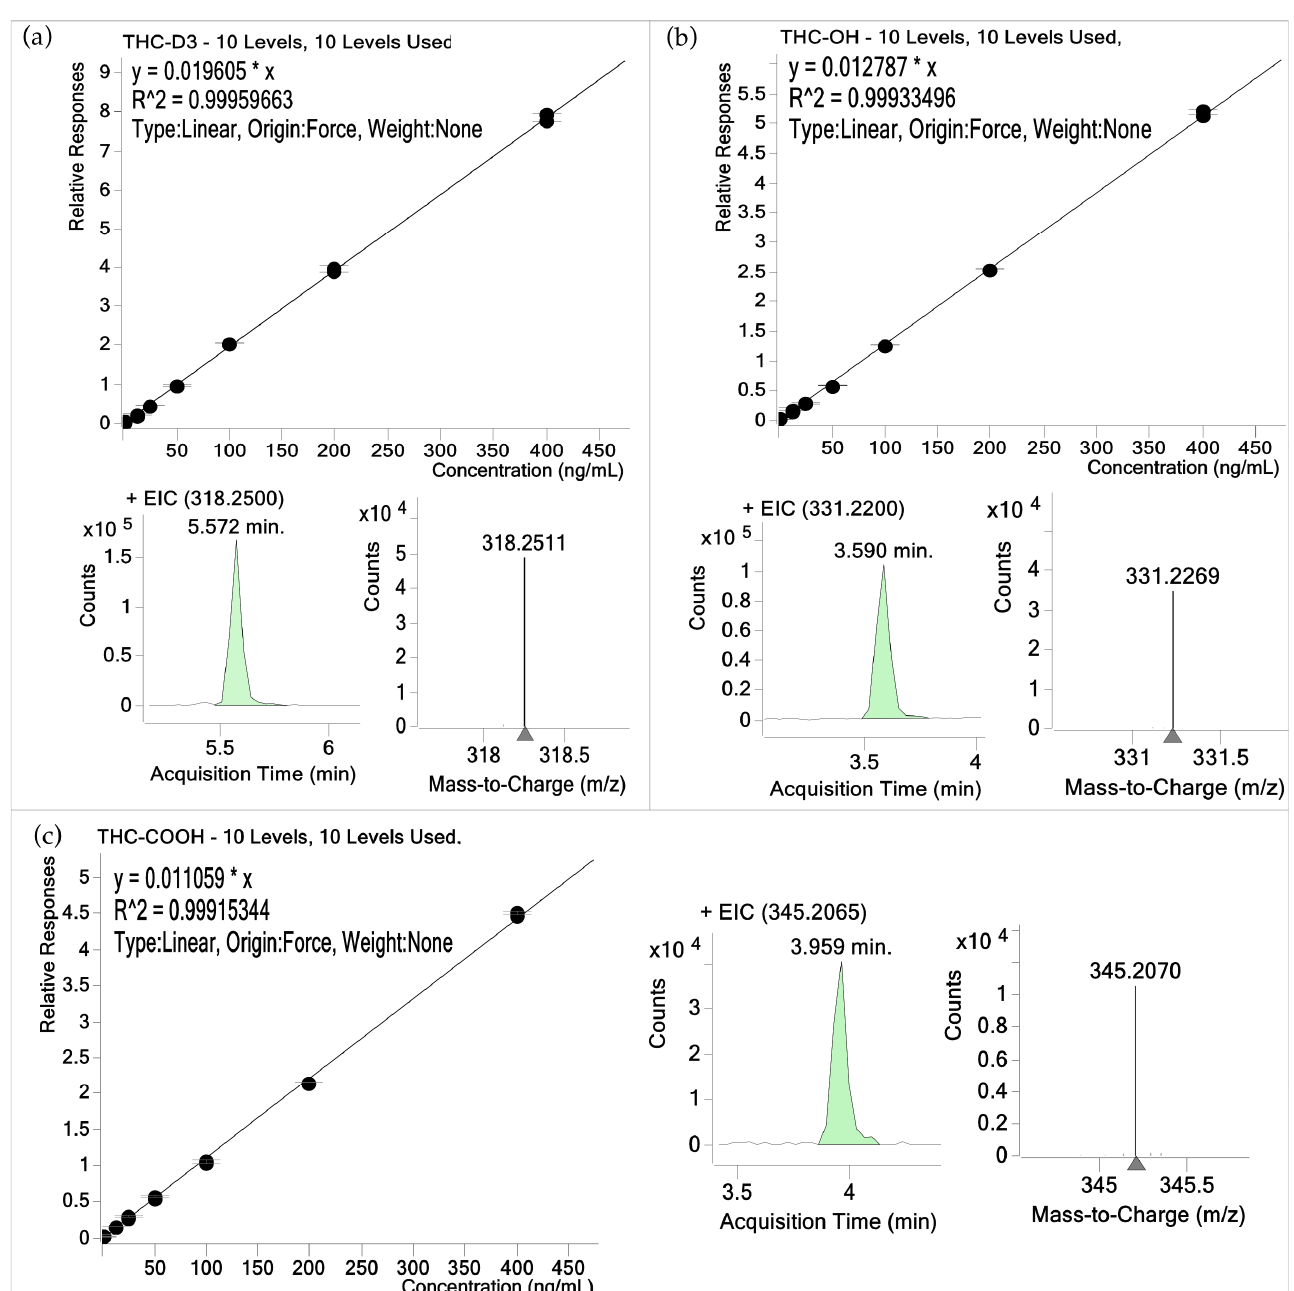
Figure 4. Calibration curves with calibration curve equation y and coefficient of determination R 2 , chromatograms and mass spectra for ( a ) Δ 9-THC-D 3 ( b ) THC-OH ( c ) THC-COOH.